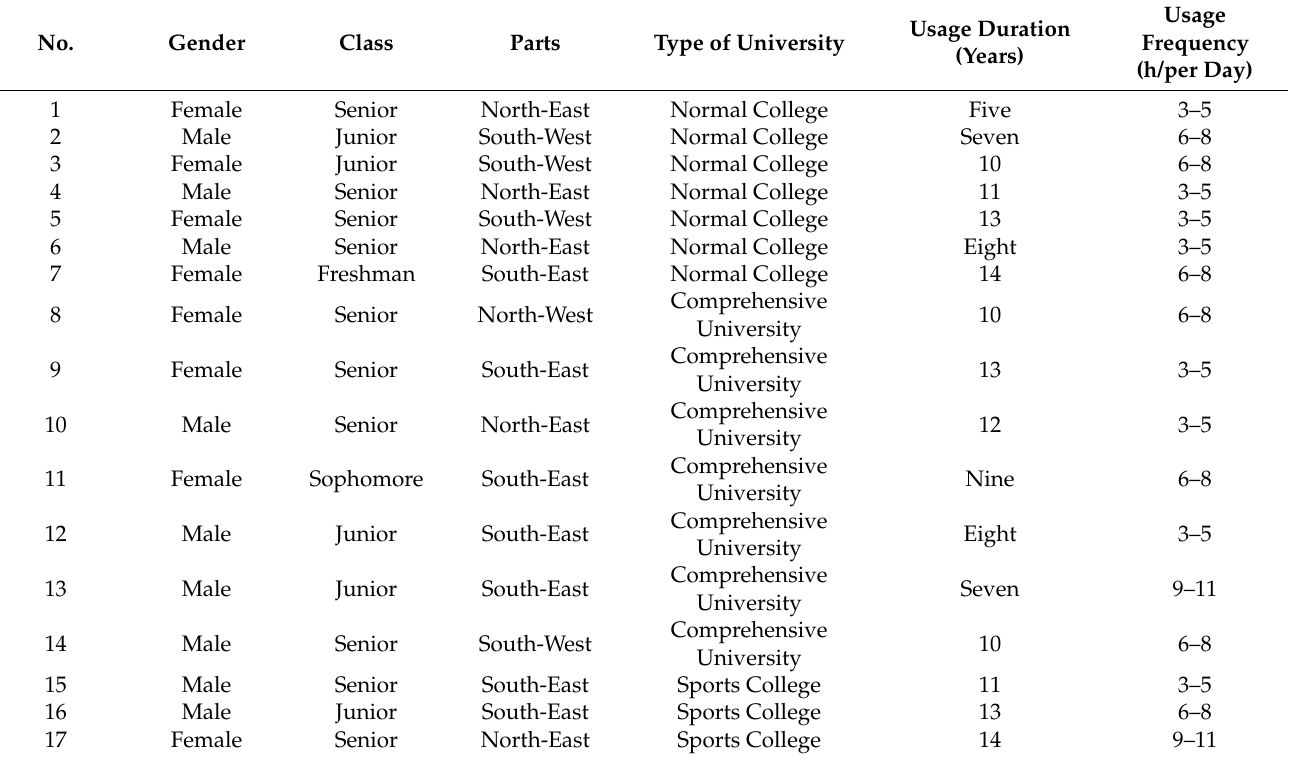
Table 1. Demographics for the sample of participants (N =